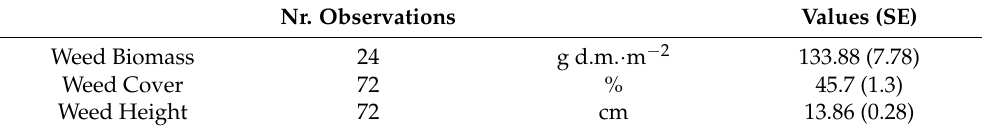
Table 4. Parameter mean values recorded before the mowing treatments of the first trial (standard